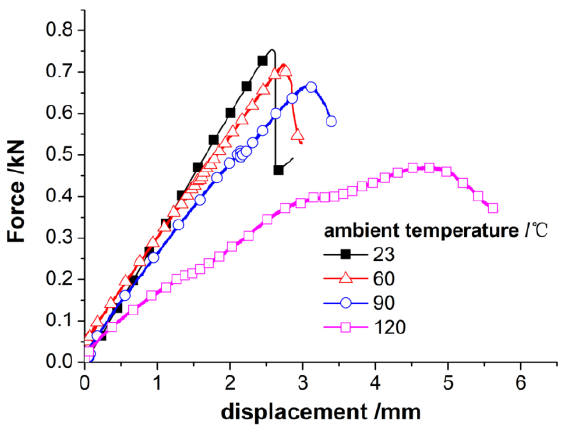
Figure A3. Representative curves tested at different ambient